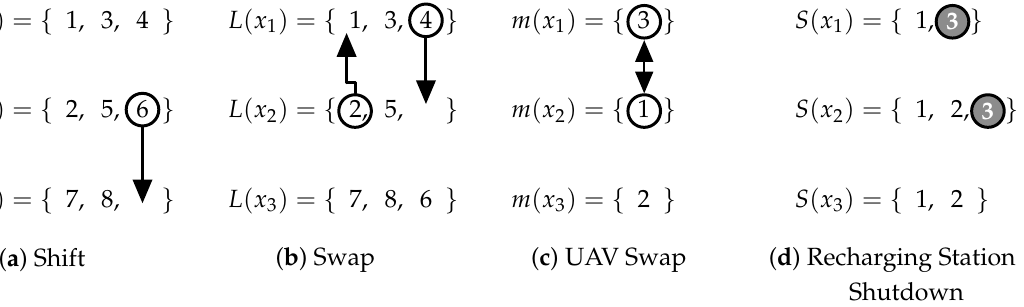
Figure 6. Illustration of actions executed by the neighborhood functions.